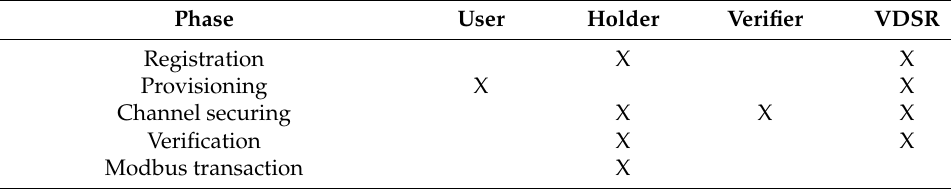
Table 2. Modbus devices’ behaviors.